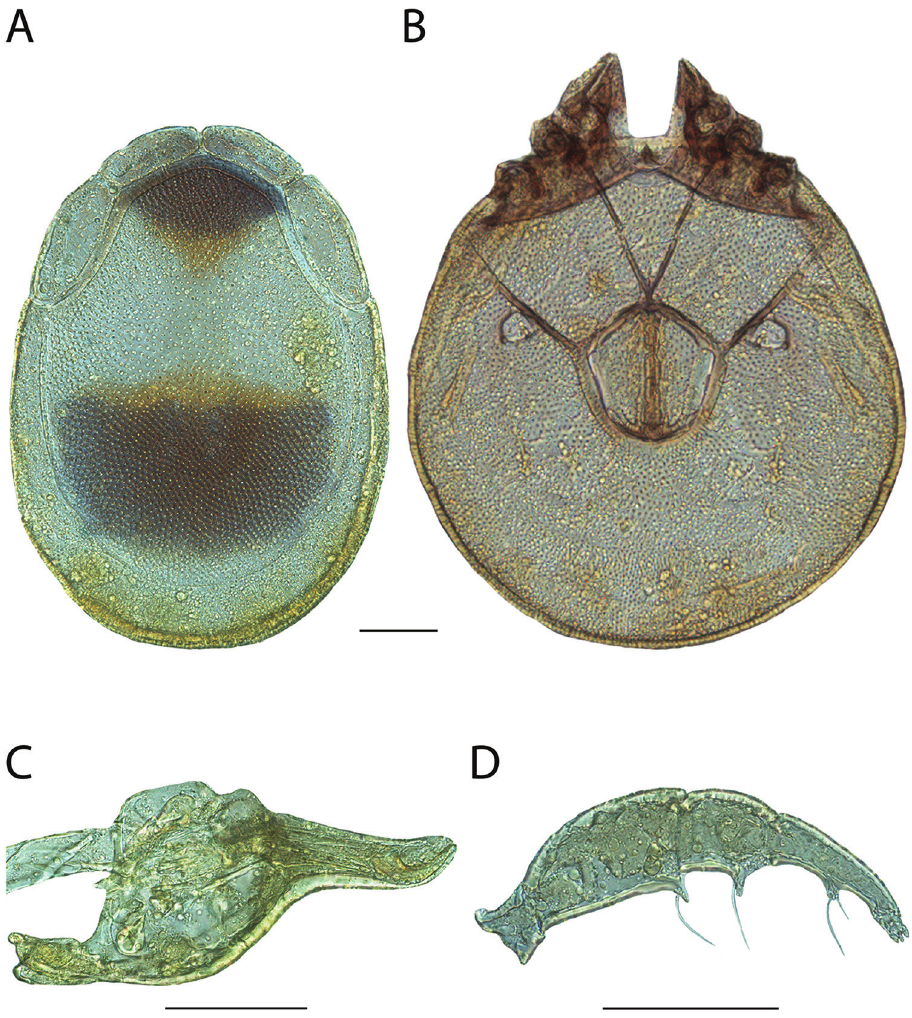
Figure 115. Torrenticola kittatinniana female: A dorsal plates B venter (legs removed) C subcapitulum D pedipalp (setae not accurately depicted). Scale = 100 µm.